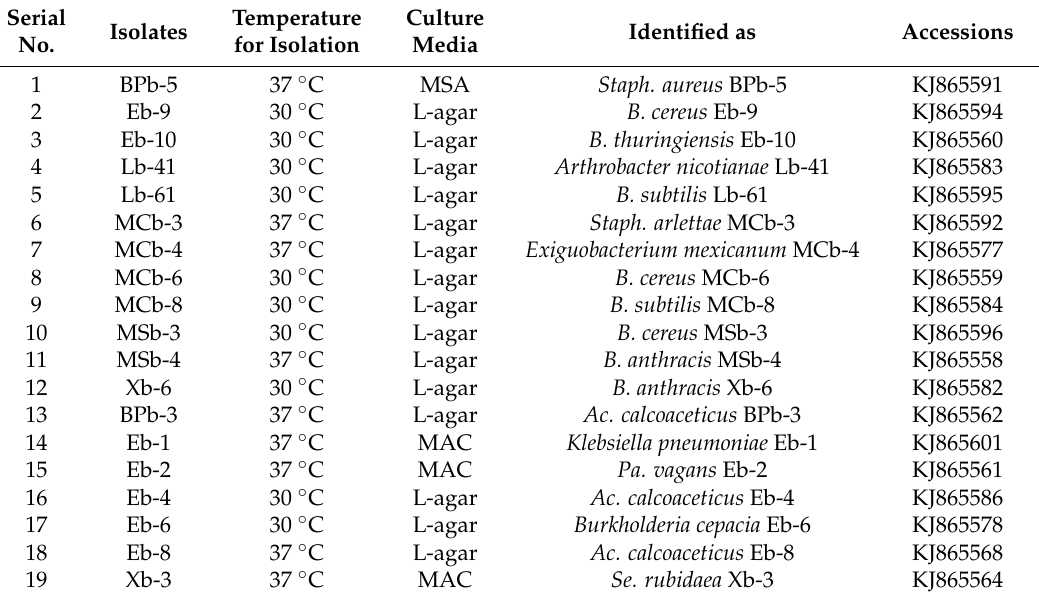
Table 2. 16S rRNA gene sequencing of bacteria isolated from cabbage at different temperatures and in different culture